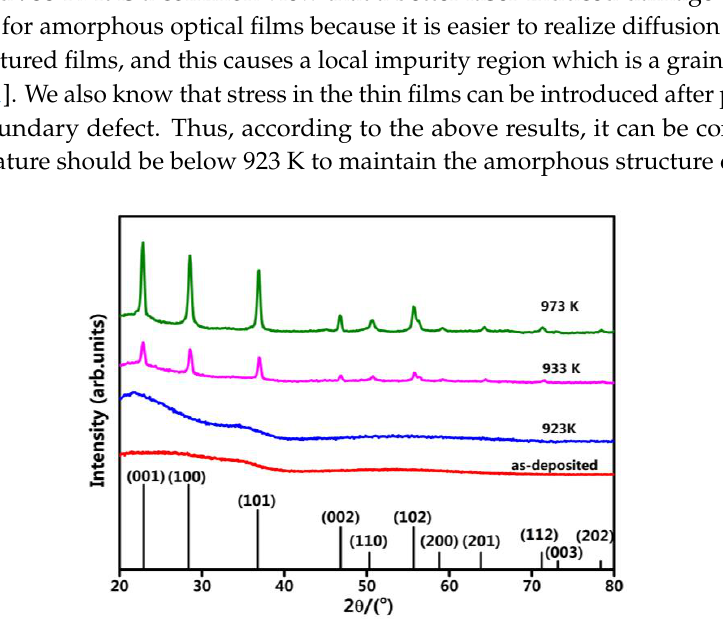
Figure 2. XRD patterns of Ta 2 O 5 film with a thickness of 500 nm; the crystal phase of Ta 2 O 5